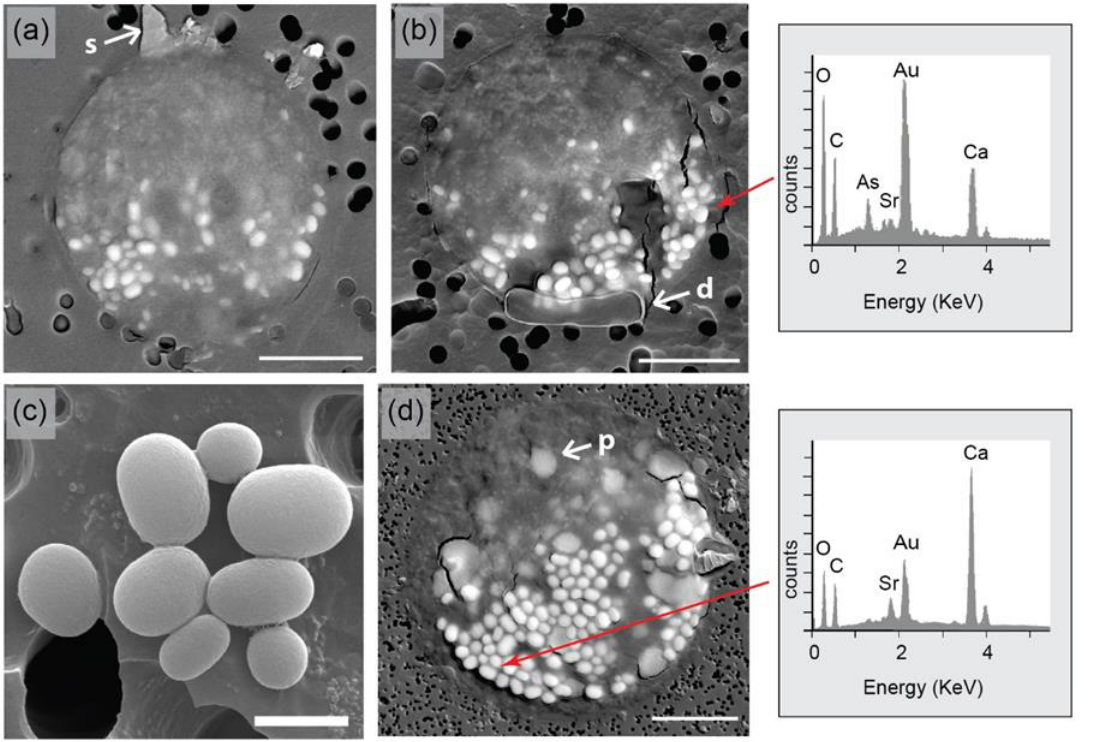
Figure 2. Micropearls observed in Lake Titicaca ( Sr-Titicaca /MC4), compared to Sr-Tetraselmis micropearls of Lake Geneva (MC3). SEM images of dried filters. ( a , b , d ): Backscattered electron images.